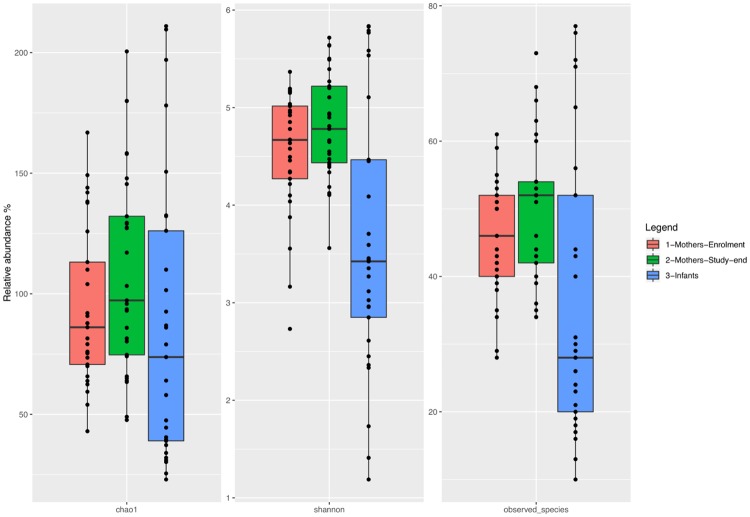
α-diversity measures of fecal microbiota.Boxplots describe α-diversity measures of fecal microbiota of GDM patients at enrolment (red bars), of GDM patients at the study end (green bars) and of their offspring (blue bars). Individual points and brackets represent the richness estimate and the theoretical standard error range, respectively.